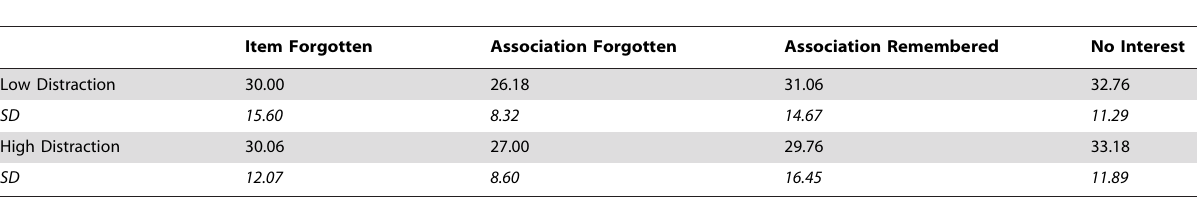
Table 1. Mean number of trials ( + SD) separated for the factors distraction and subsequent memory.